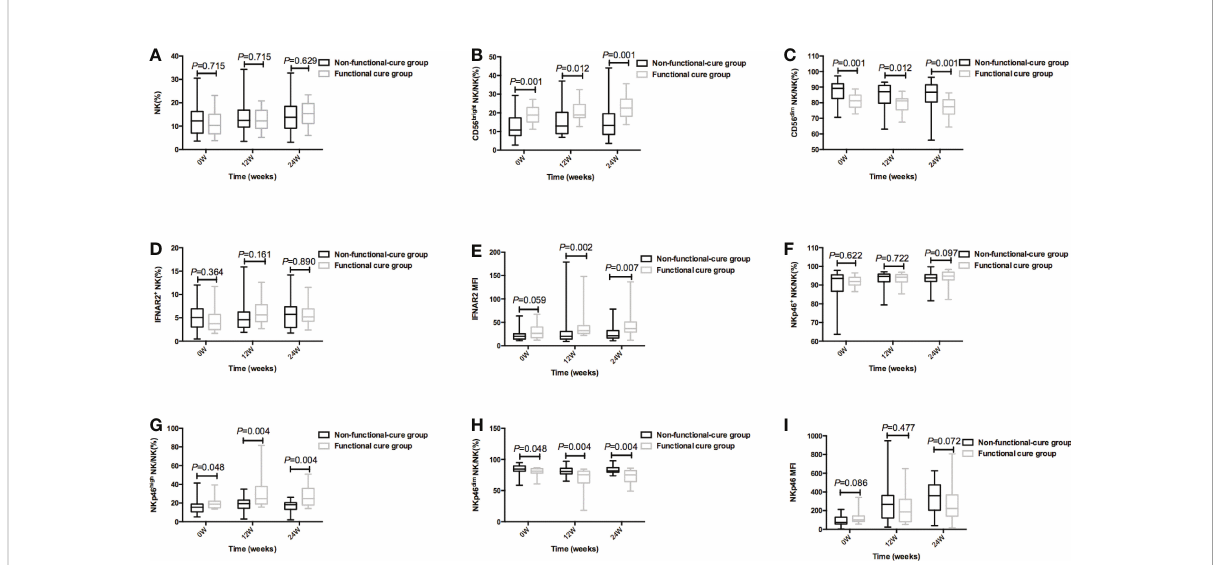
FIGURE 2 During PEG-IFN a -2a therapy, the frequency of NK cells and surface functional molecules [NK% (A) , CD56bright NK/NK% (B) , CD56dim NK/NK% (C) , IFNAR2+ NK/NK% (D) , IFNAR2 MFI (E) , NKp46 NK/NK% (F) , NKp46high NK/NK% (G) , NKp46dim NK/NK% (H) , and NKp46MFI (I) ] between Non-functional-cure group and Functional cure group were compared before therapy and at 12 weeks and 24 weeks of therapy, respectively. P<0.05 was statistically signi fi cant.